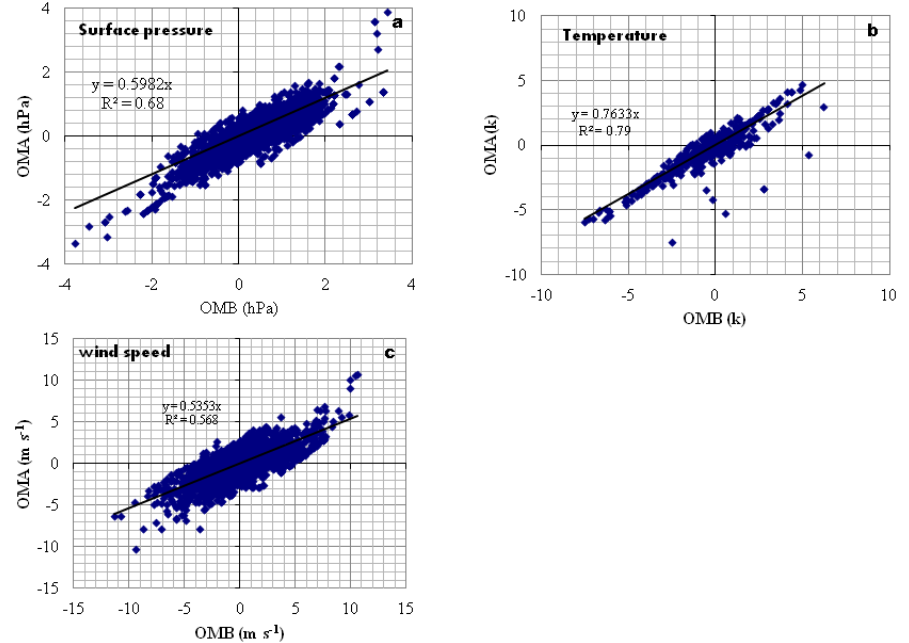
Figure 3. The scattering plot between observation minus background (OMB) and observation minus analysis (OMA) in the all-data (CON + AMSU-A + MHS + IASI ) experiment ( a : surface pressure; b : atmospheric temperature at the height of 2m; c : wind speed at the height of 10m) for 1 July